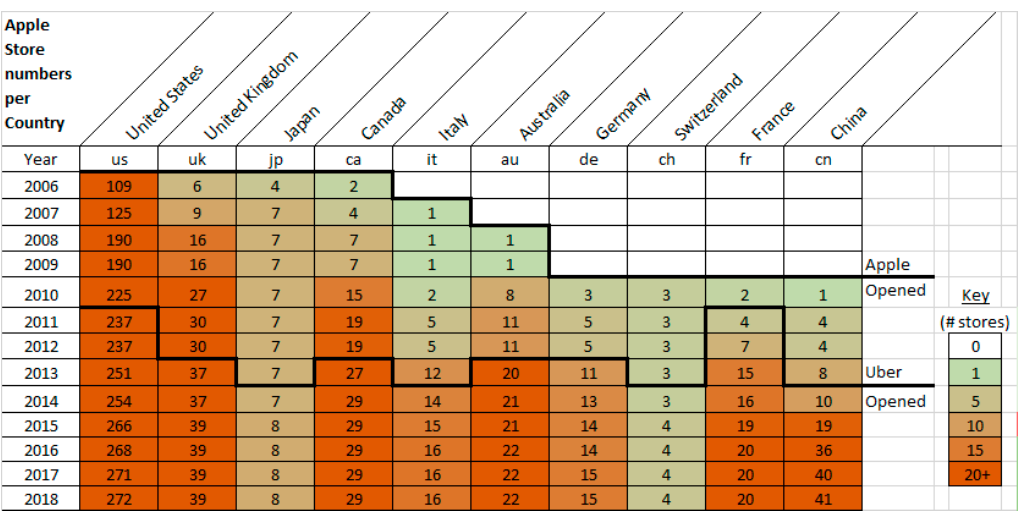
Figure 16. Apple Store opening numbers overlaid with Uber deployment numbers. The bold lines indicate initial opening in that country for Apple Store and Uber.